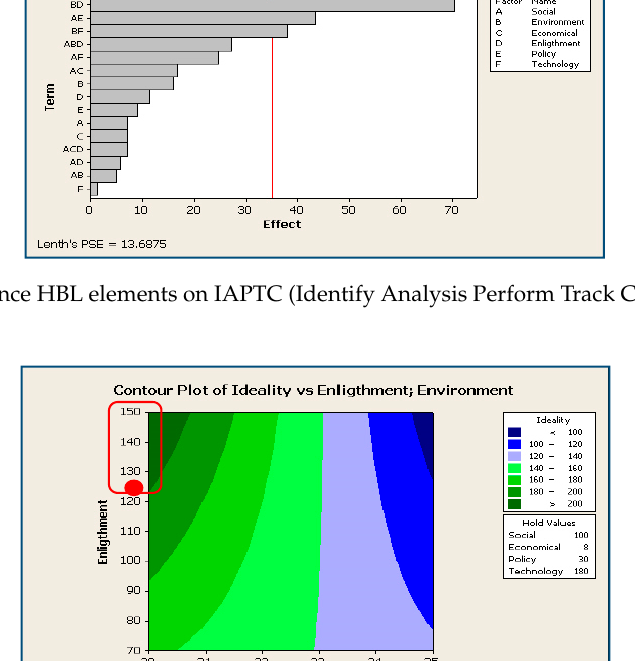
Figure 8. Impact of Environment and enterprises culture interference.